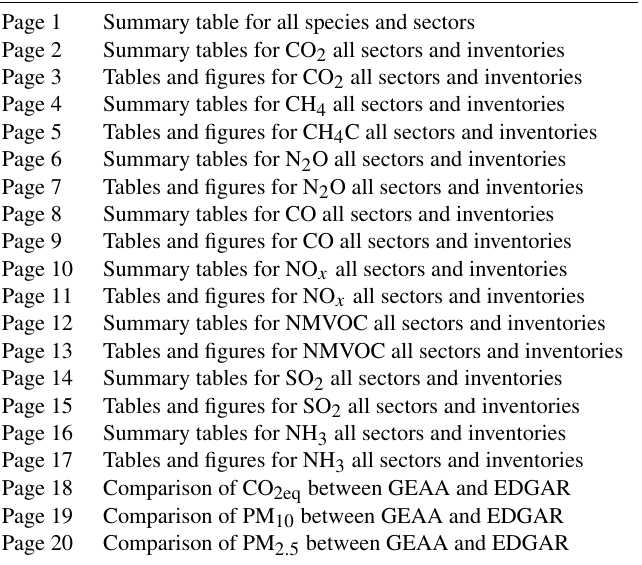
Table A6. Index of comp_geaa_ceds_edgar_tcna.xlxs in the